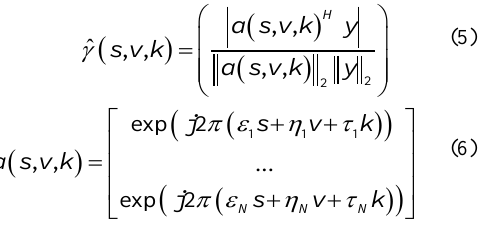
Figure 2. The two skyscrapers in Luijiazui Zone are displayed based on the averaged TerraSAR-X intensity image. The red rectangle in the top figure denotes SWFC, and the yellow rectangle denotes Jin Mao